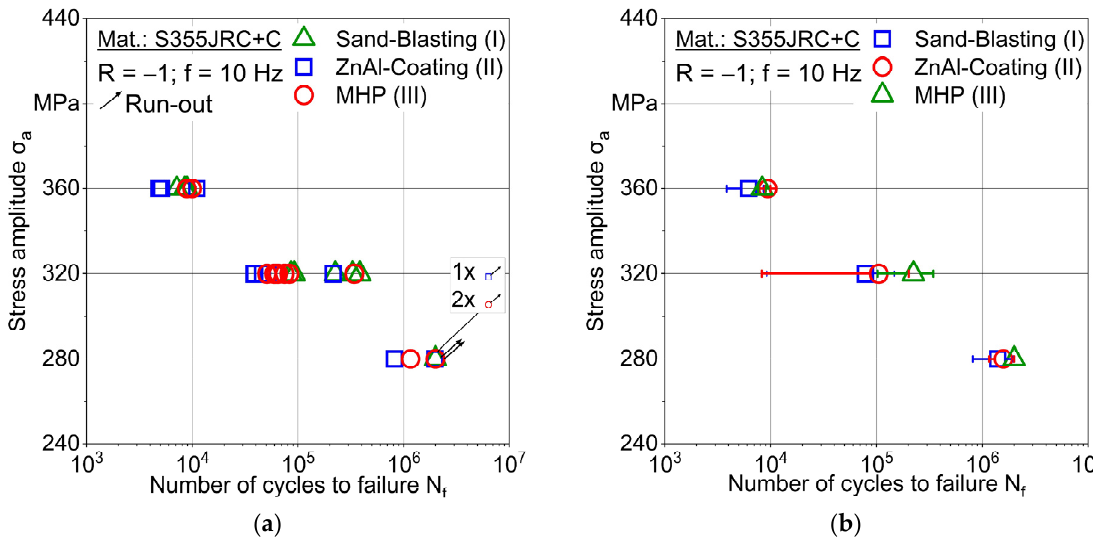
Figure 17. S-N diagrams of conditions sand-blasting (I), ZnAl-coating (II) and machine hammer- peened (III), ( a ) individual lifetime values, ( b ) average lifetime values with standard deviations.